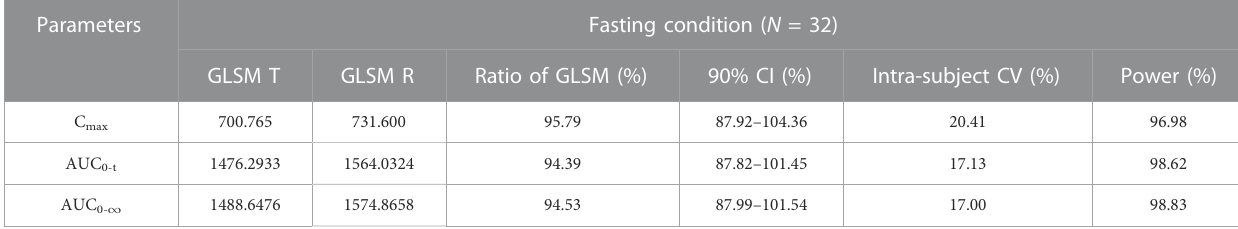
TABLE 3 Bioequivalence assessment of pharmacokinetic parameters of esomeprazole after a single dose 20 mg of test and reference esomeprazole magnesium enteric-coated tablet in healthy Chinese subjects under fasting conditions.